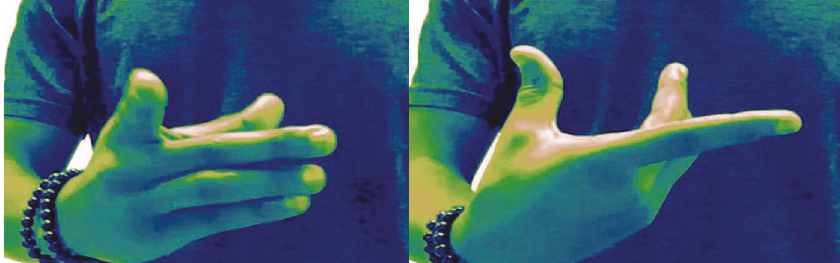
Figure 3: Different hand orientation for the Amharic character.